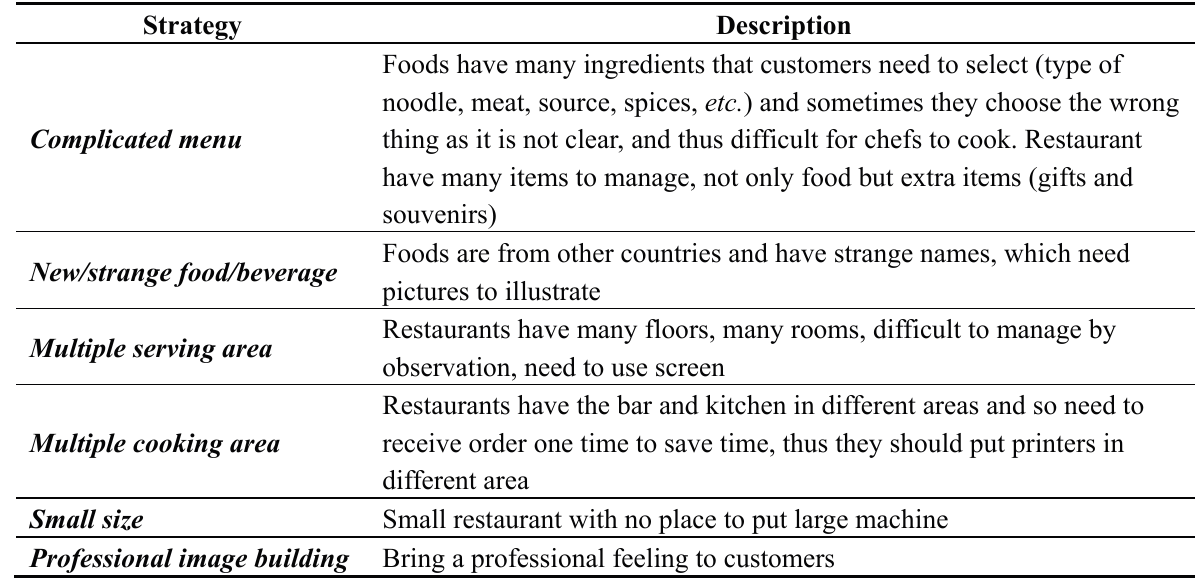
Table 5. Strategies